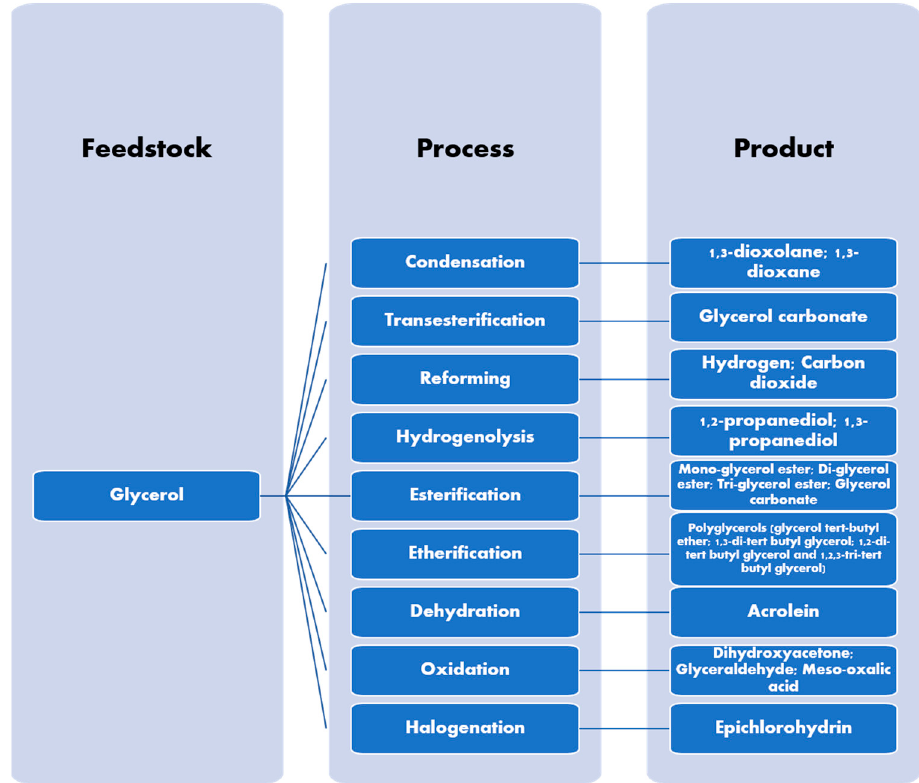
Figure 3. Di ff erent Chemical pathway for glycerol conversion to chemical derivatives (Adapted Figure 3. Different Chemical pathway for glycerol conversion to chemical derivatives [Adapted from from [32].